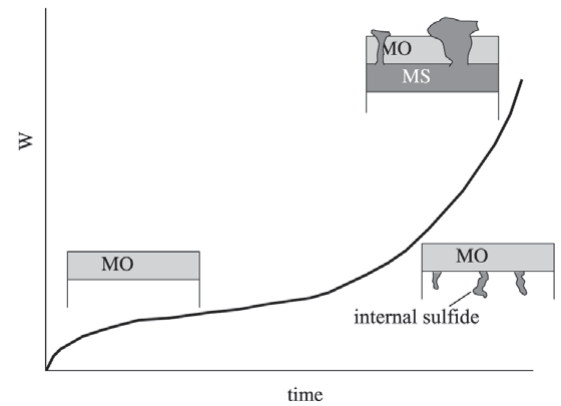
Figure 5. The usual degradation sequence leading to breakaway corrosion under oxidizing-sulfidizing